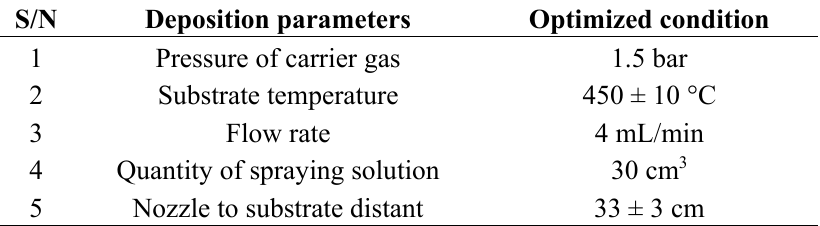
Table 1 Optimized deposition